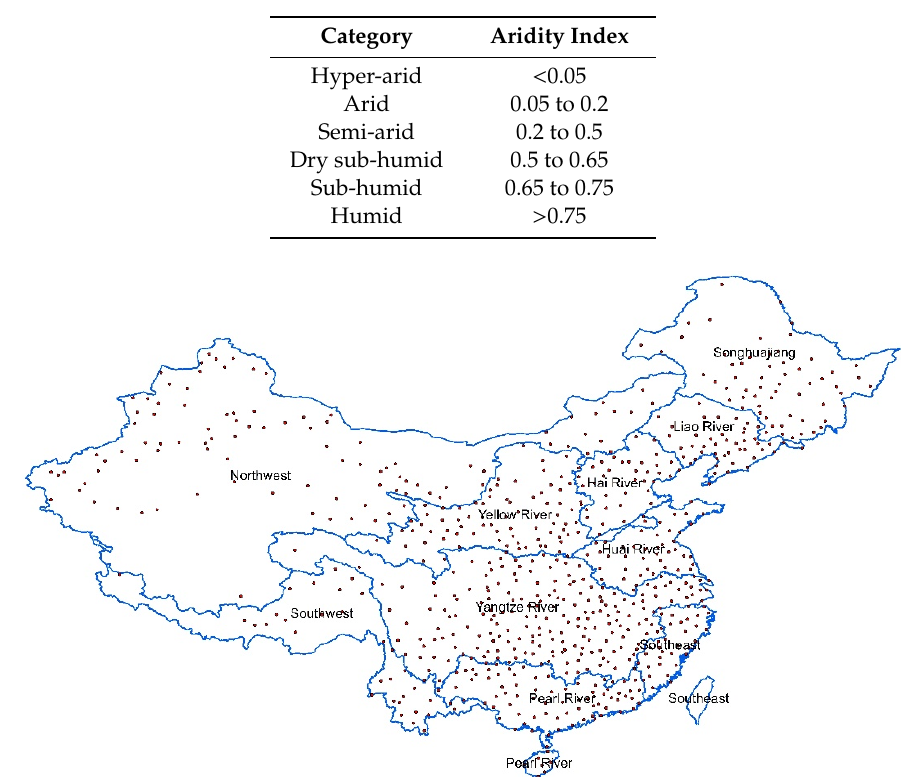
Figure 1. Distribution of the 713 used climate stations in the ten first-level basins in China. The ten basins include Songhuajiang (1), Liao River (2), Hai River (3), Yellow River (4), Huai River (5), Yangtze River (6), Southeast rivers (7), Pearl River (8), Southwest rivers (9), and Northwest rivers (10).